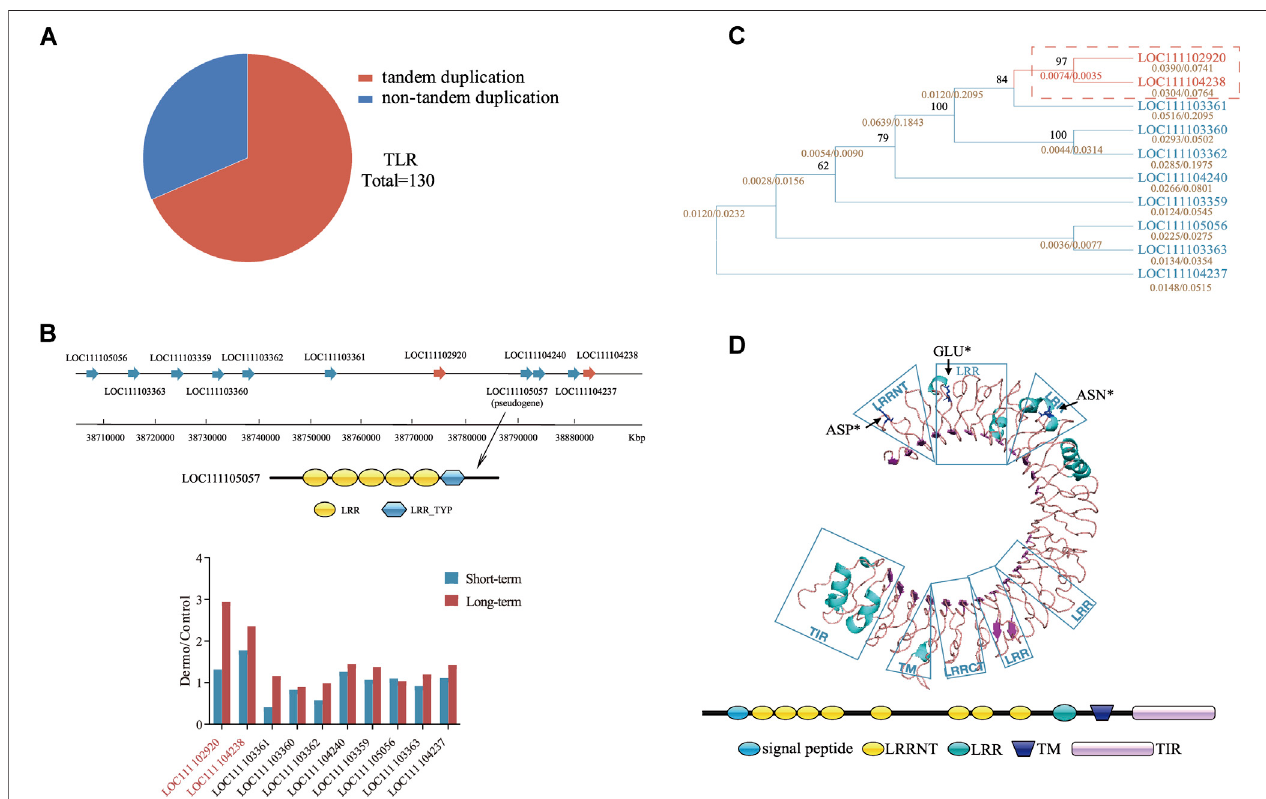
FIGURE 6 | Tandem duplication and positive selection of TLRs in C. virginica . (A) , Tandem repeats as the major source of TLRs duplication in C. virginica. (B) , The largesttandemrepeatcluster (Top) anddivergentexpressionpatterns (Bottom) oftandemlylinkedTLRsinNC_035786.1under P.marinus challenge.Thewidearrows represent TLR genes, and genes with red background are differentially expressed under P. marinus challenge. A pseudogene LOC111105057 was detected in this repeat cluster. (C) , Evolutionary relationships of duplicated TLRs. The calculated d N /d S ( ω ) values (gold) and bootstrap values are shown for each branch. The branches with ω values > 1.0 are marked with red rectangle. The differential genes under P. marinus challenge that are positively selected are boxed with red dash lines. (D) , Structural modeling of TLR depicting sites (blue) under positive selection. Positive selection sites (Asp 27 , Glu 62 , Asn 199 ) are represented by black